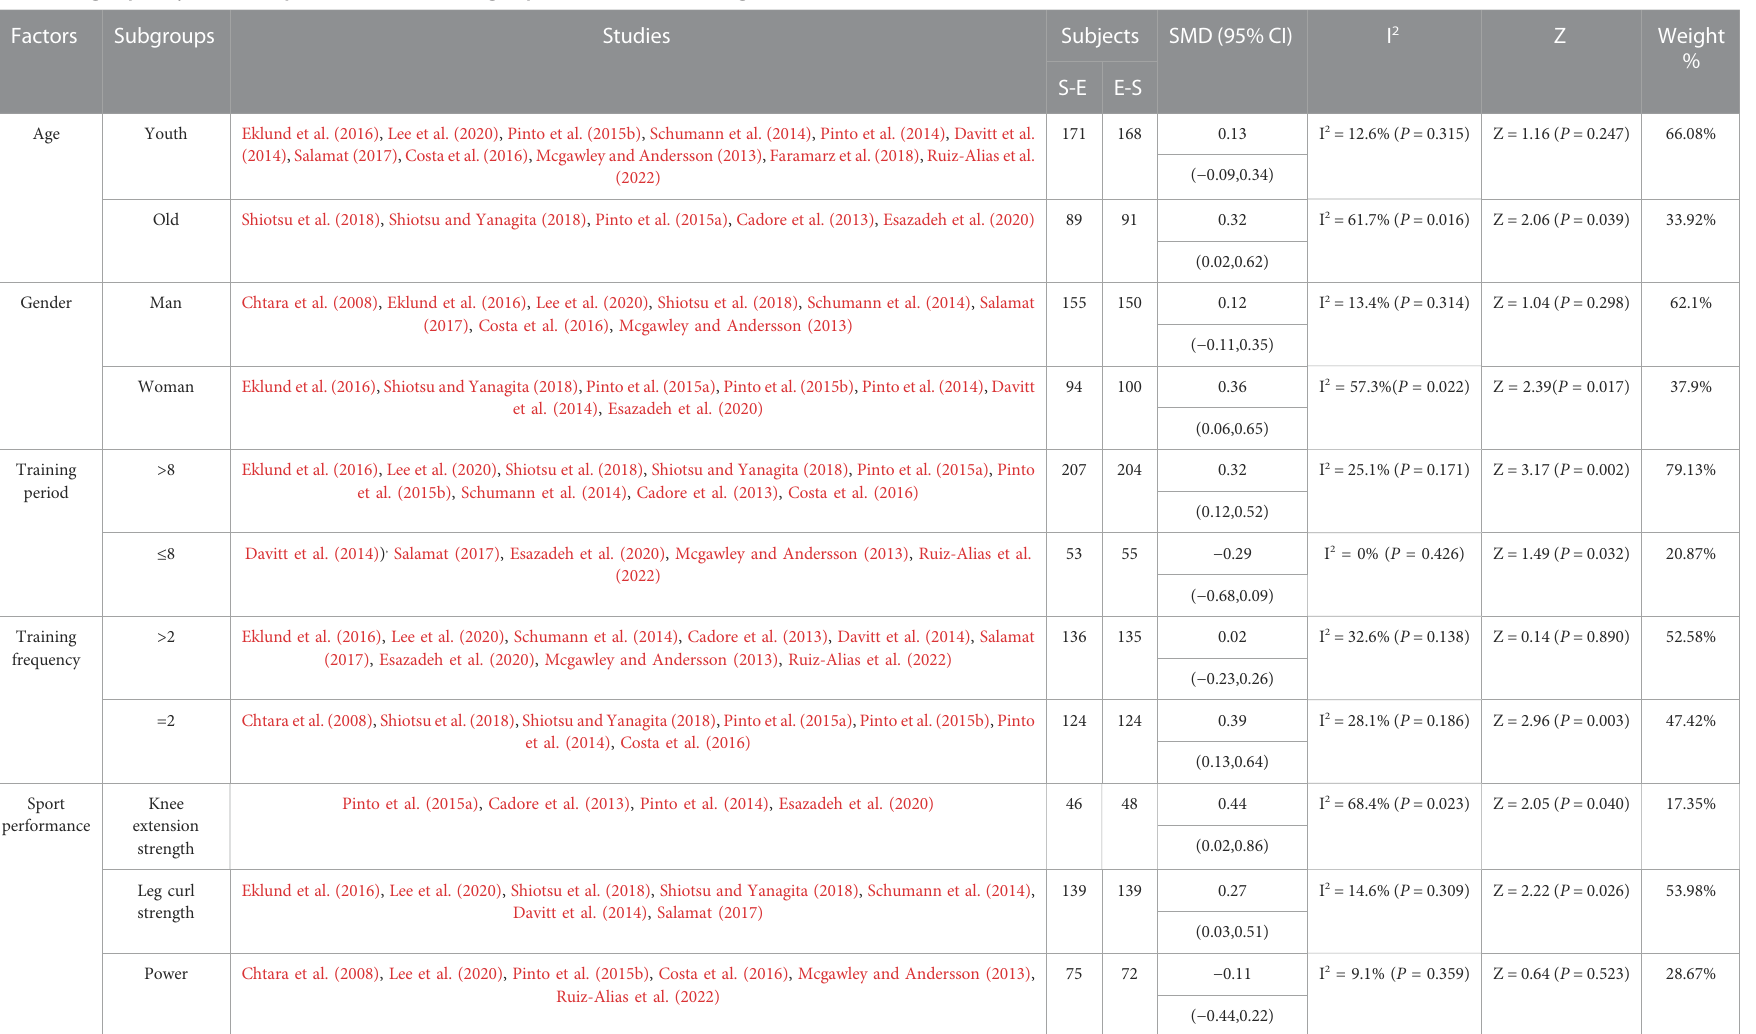
TABLE 4 Subgroup analysis of the impact of concurrent training sequence on lower limb